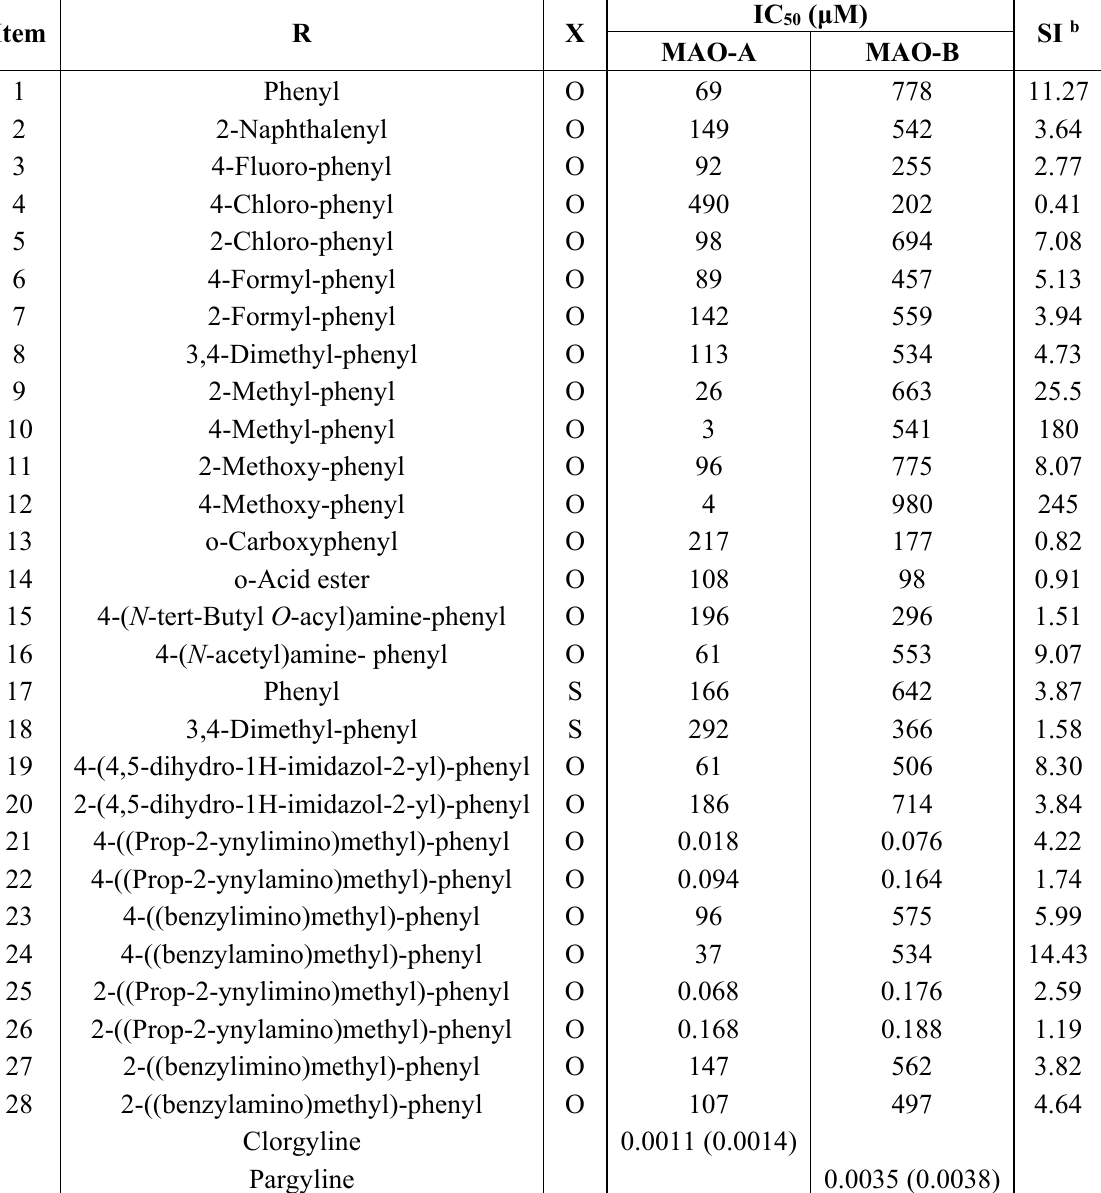
Table 1. Monamine oxidase inhibitory activity of compounds 1 – 28 a